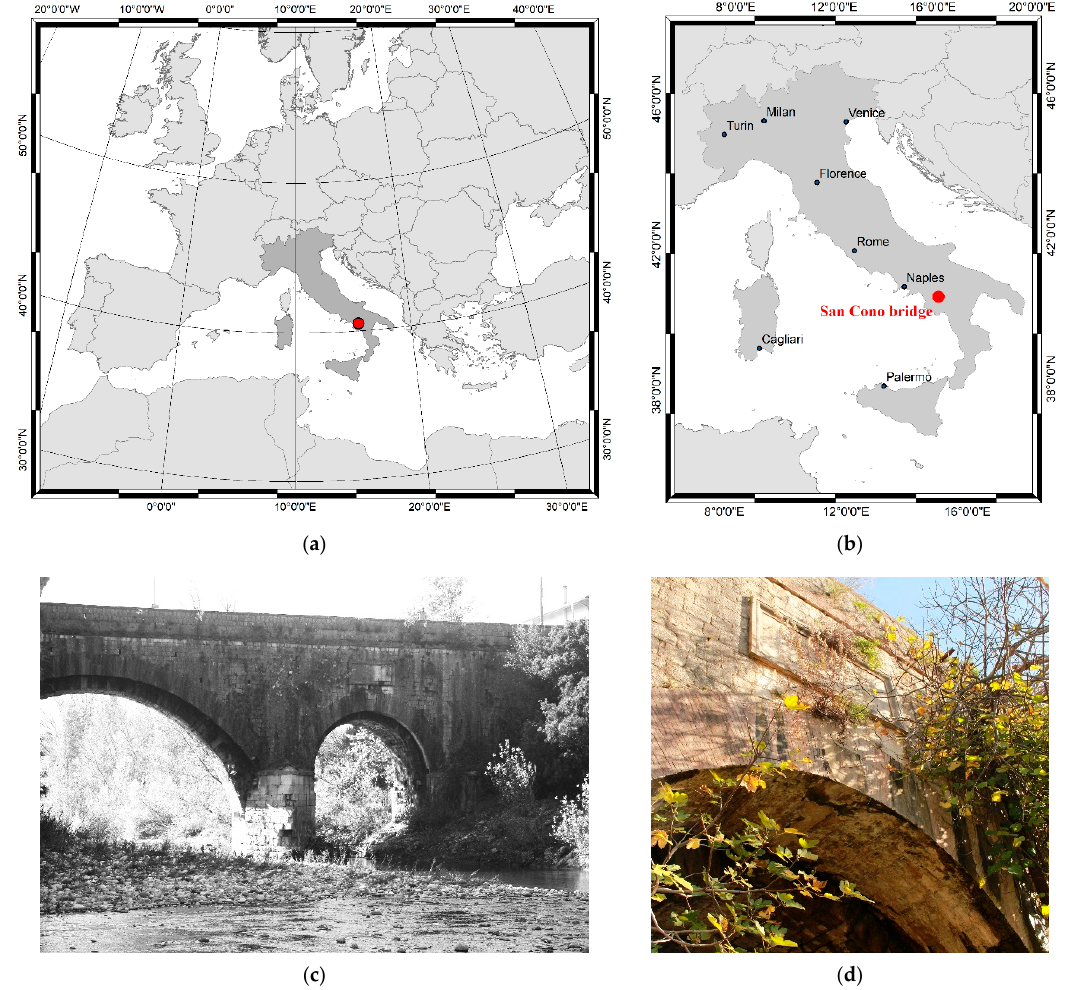
Figure 3. San Cono bridge: location ( a , b ) and panoramic images of masonry bridge ( c , d ).